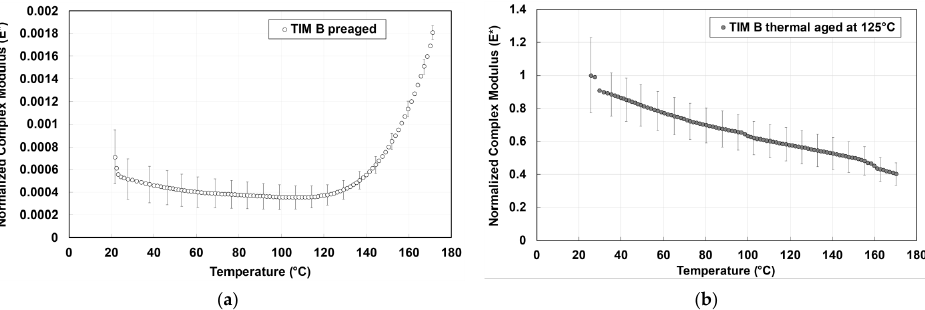
Figure 10. Complex modulus, ( a ) TIM B preaged, and ( b ) TIM B thermal-aged at 125 °C.